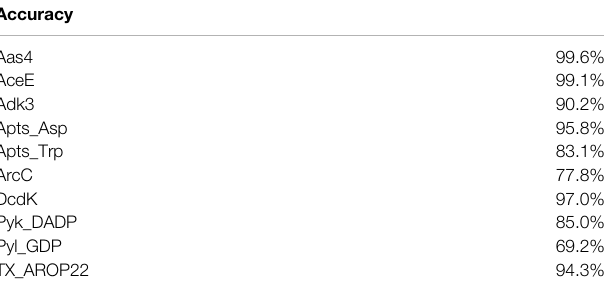
TABLE 1 | Accuracies of Snorkel ’ s weak labels for 10 manually labelled reactions. Accuracy